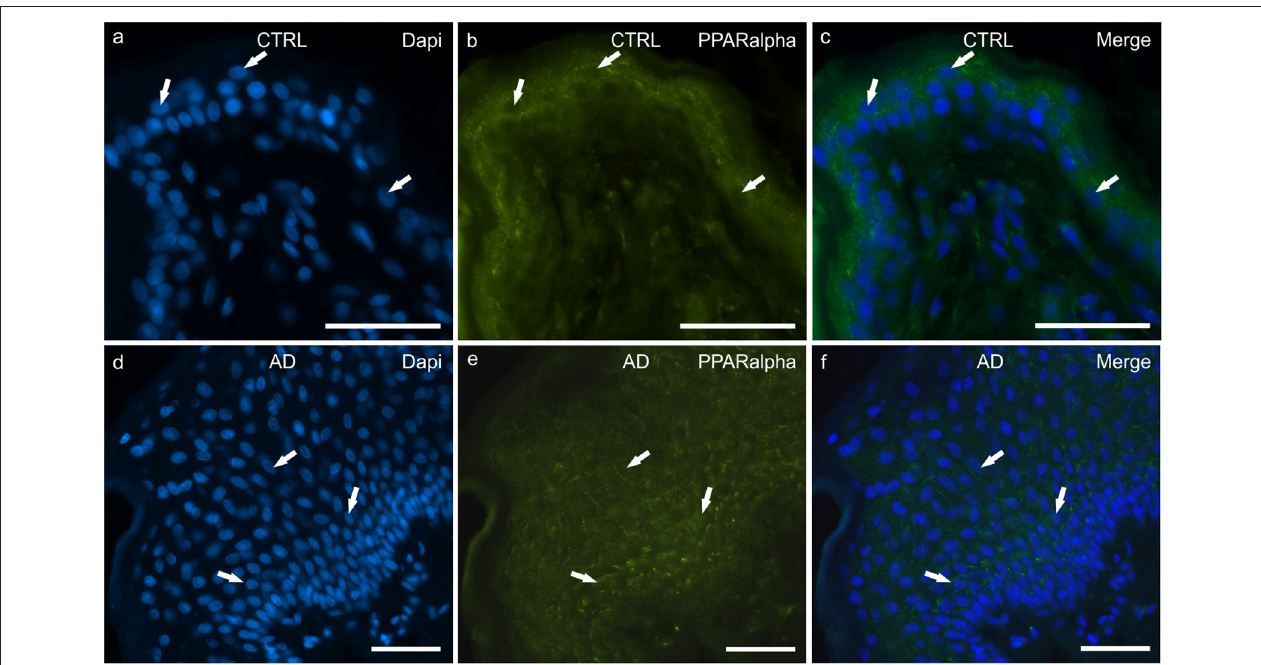
FIGURE 4 | Photomicrographs of cryosections of canine skin showing peroxisome proliferator-activated receptors alpha (PPAR α ) immunoreactivity (IR) in the tissues of the healthy dogs (CTRL) (a–c) and in the dogs with atopic dermatitis (AD) (d–f) . (a–c) The arrows indicate the DAPI-labeled nuclei of some keratinocytes showing moderate cytoplasmic PPAR α -IR. (d–f) The arrows indicate the DAPI-labeled nuclei of some keratinocytes showing moderate cytoplasmic PPAR α -IR in the cells of the basal and the suprabasal layers. Bar, 50 µ